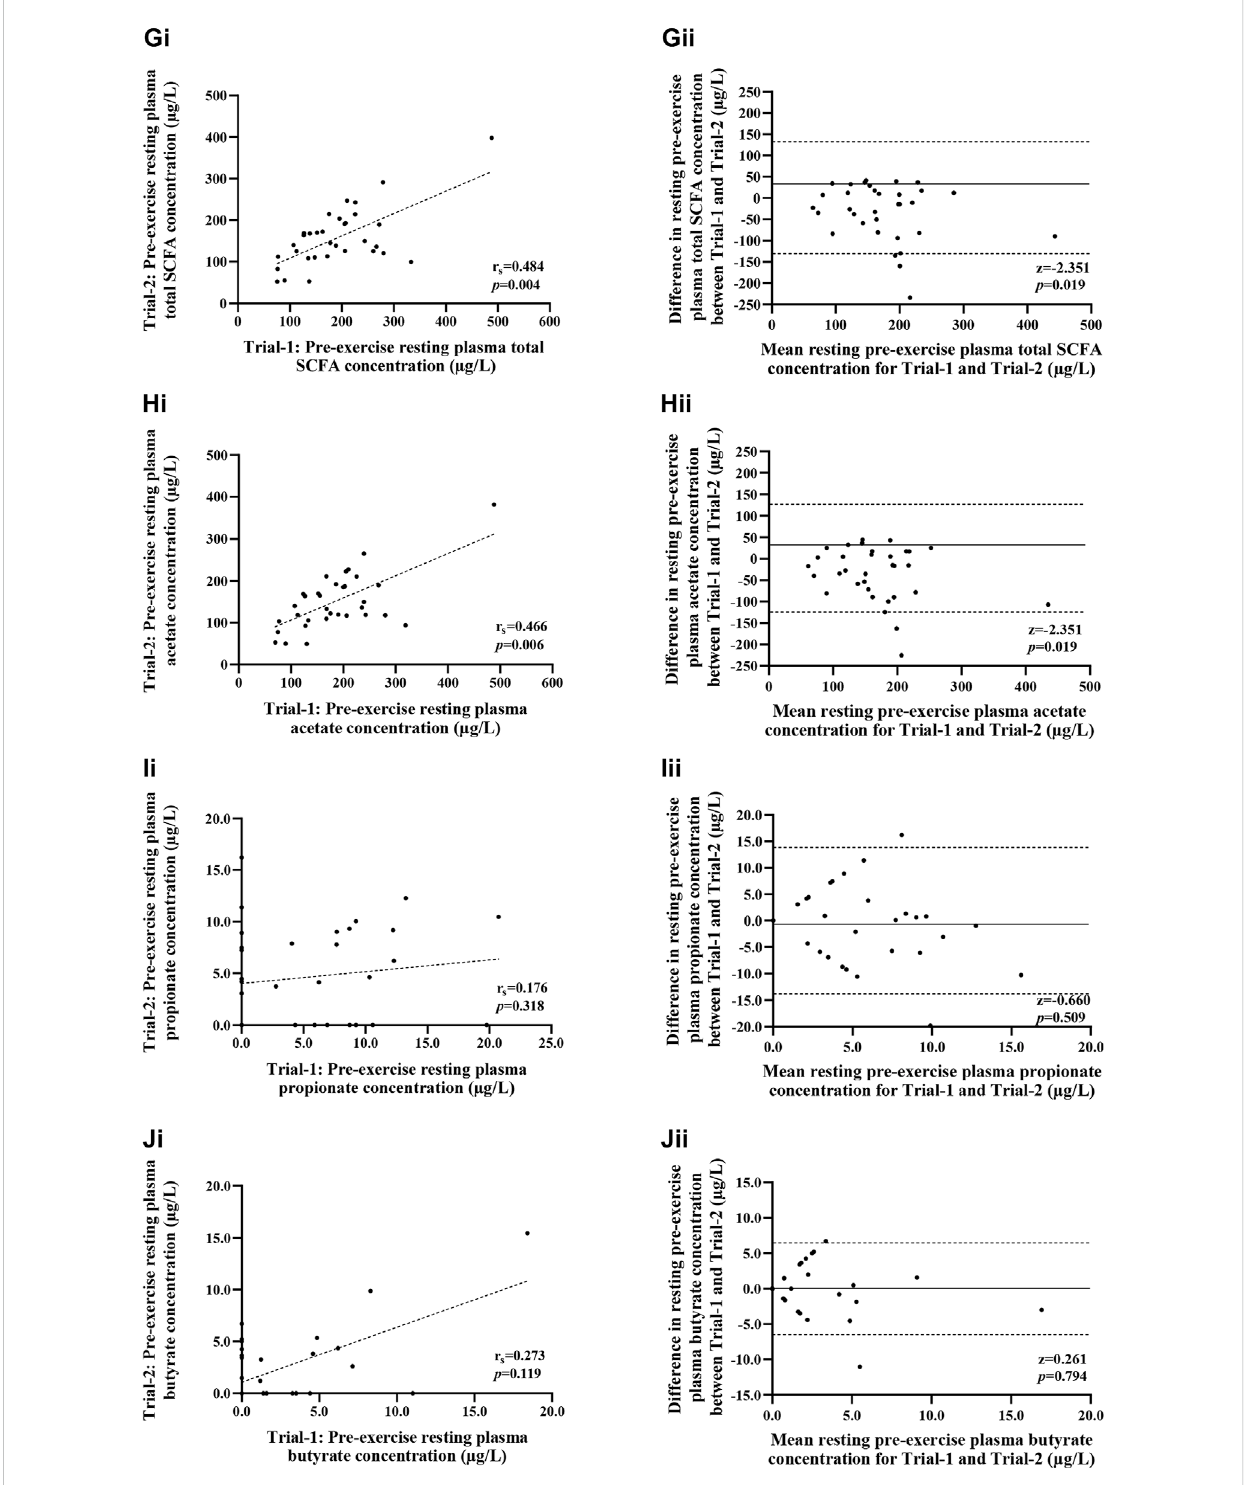
FIGURE 3 Correlation i) and Bland-Altman plot ii) comparing combined data from Trial-1 and Trial-2 for resting pre-exercise fecal total SCFA (A) , fecal acetate (B) , fecal propionate (C) , fecal butyrate (D) , fecal valeric (E) , fecal caproic (F) , plasma total SCFA (G) , plasma acetate (H) , plasma propionate (I) and plasma butyrate (J) . Dotted line represents limits of agreement (±2 SD; 95% con fi dence interval), and the solid line represents mean bias between